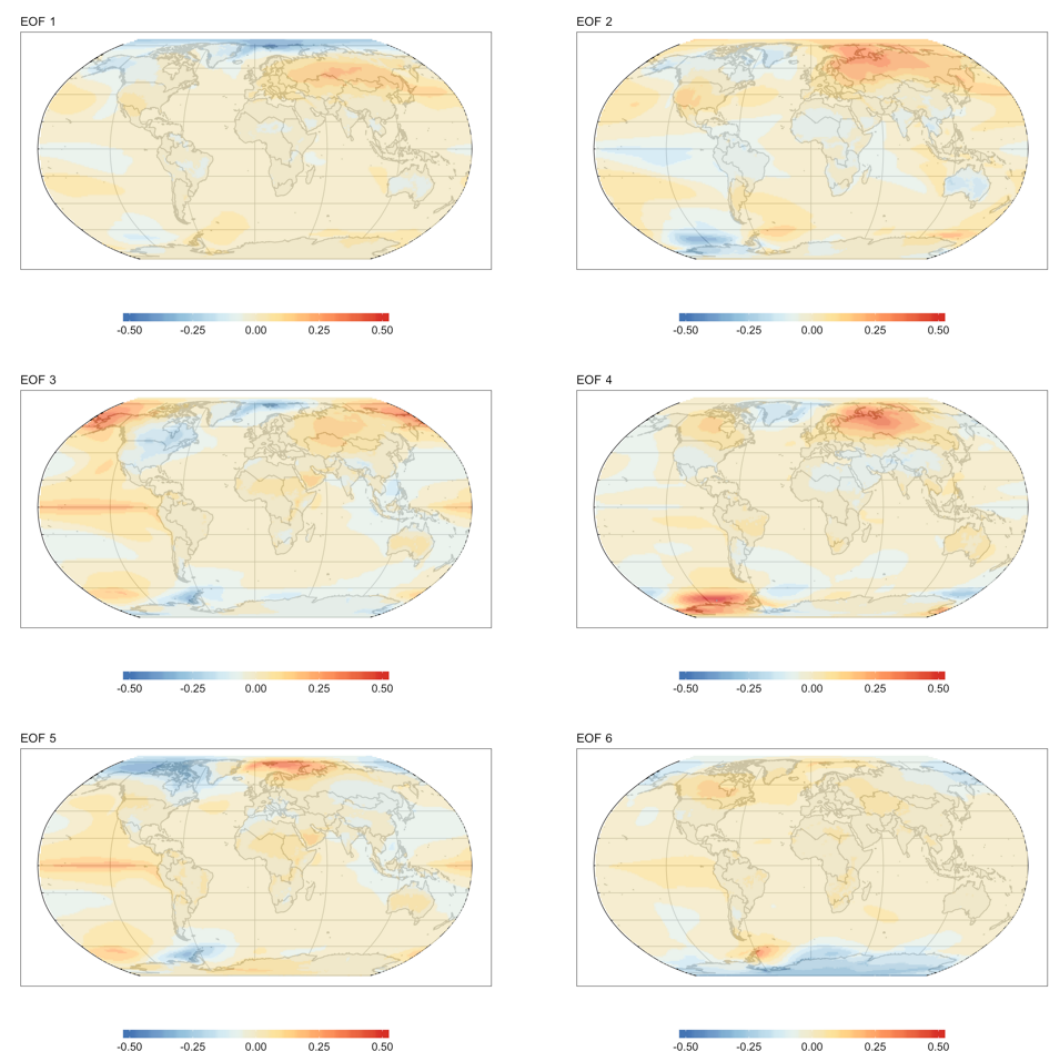
Figure 6. Spatial visualizations of the EOFs 1–6 basis functions. EOF grid cell values are scaled such that the magnitude of the largest value is 1. These components capture large-scale patterns of variability. EOFs 2, 3, and 5 all feature a temperature anomaly in the eastern Pacific. These same components can be seen in Fig. 5 to have some periodicity on 3–5-year timescales, suggesting that they may be rooted in physical processes in the ESM the model was trained on.